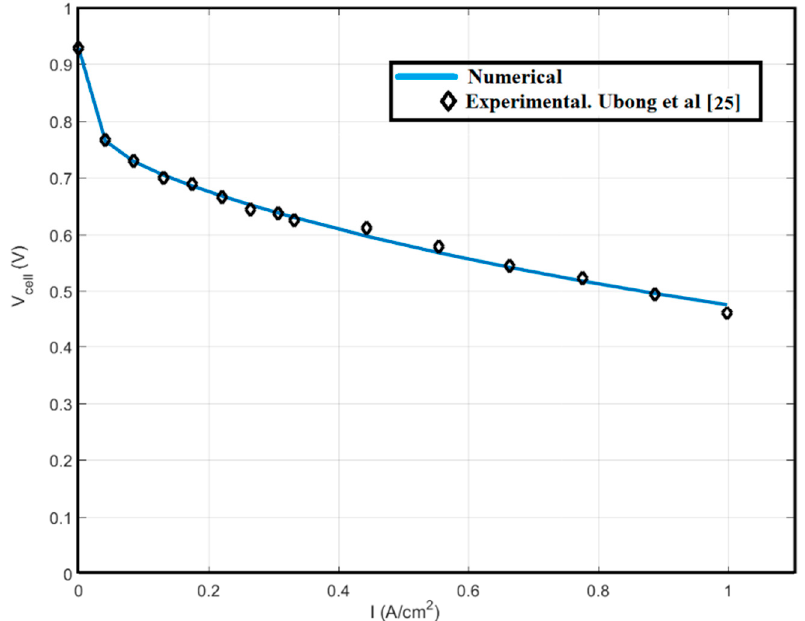
◦ C and experimental